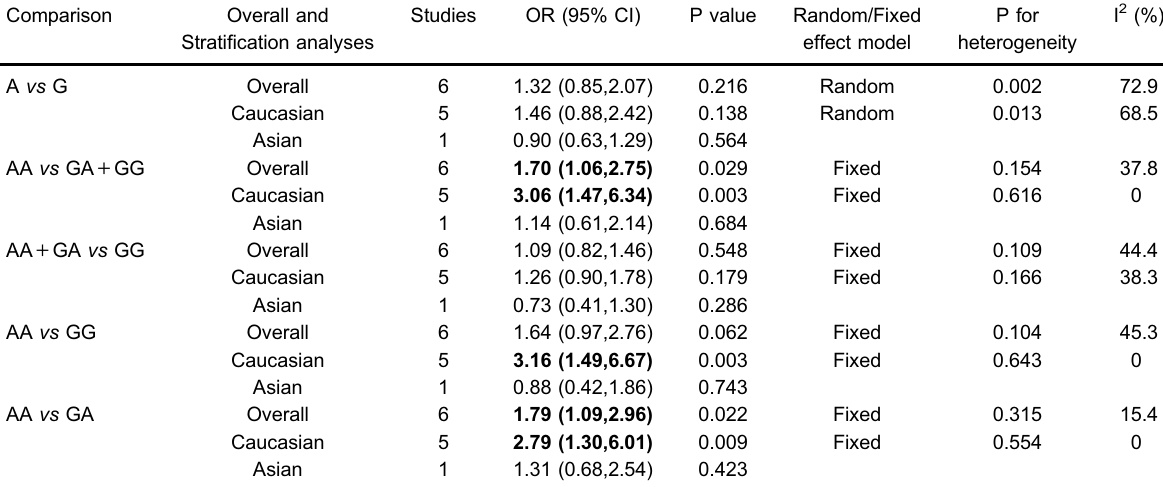
Table 2. Meta-analysis of associations between the Val66Met polymorphism and cognitive impairment in patients with Parkinson ’ s disease. Comparison Overall